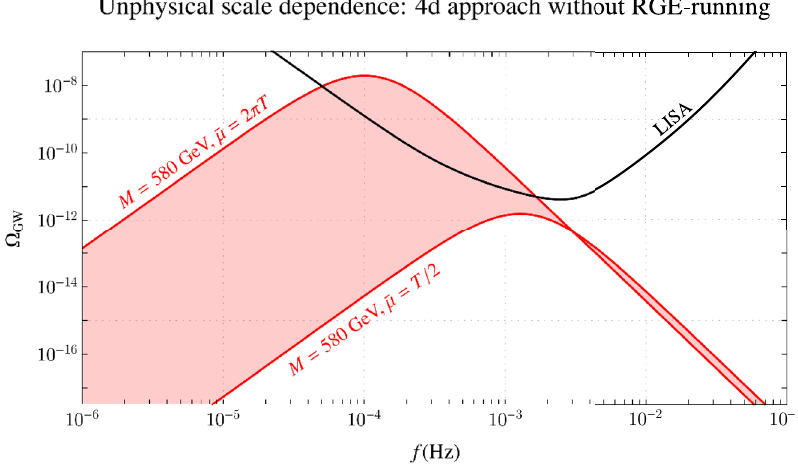
Figure 1 . A common method of calculating the thermal parameters of a phase transitions is very sensitive to the choice of renormalisation scale. Here we show this dependence in the popular daisy- resummed “4d approach” for a benchmark point of our SMEFT defined by eq. (1.1), without the renormalisation group (RG) running of couplings. The LISA signal-to-noise ratios are 6 and 210 for the renormalisation scales ¯ µ = T/ 2 and 2 πT respectively, for the calculation of which we have used PTPlot [6] and assumed a three year mission